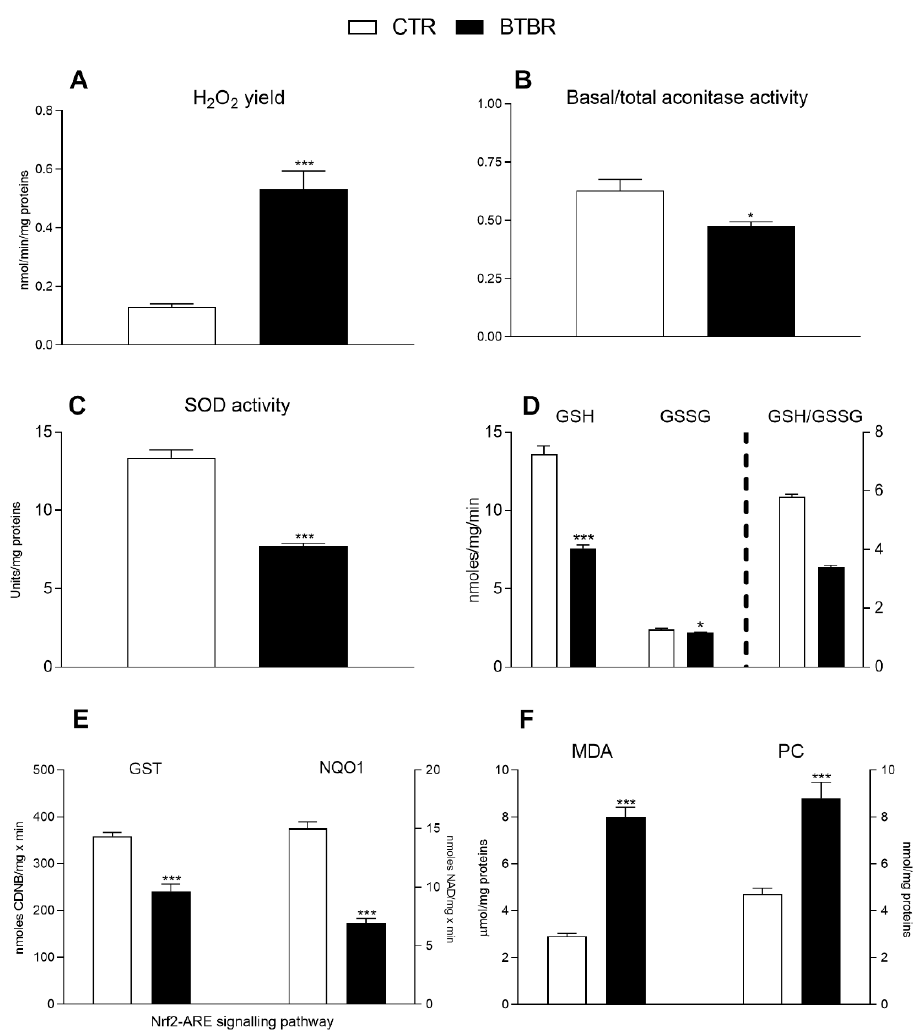
Figure 7. Hepatic oxidative stress profile and antioxidant/detoxifying defenses in control and BTBR mice. Hydrogen peroxide (H 2 O 2 ) release ( A ), basal/total aconitase ( B ) and superoxide dismutase (SOD) activity ( C ) were determined in hepatic isolated mitochondria. Reduced glutathione (GSH), glutathione oxidized (GSSG) content (( D ), left Y axis) and ratio GSH/GSSG (( D ), right Y axis), glu- tathione transferase (GST) and NAD(P)H Quinone Dehydrogenase (NQO1) levels ( E ) were evaluated in hepatic tissue. Hepatic levels of malondialdehyde (MDA) and protein carbonyls (PC) ( F ). Data are presented as means ± SEM from n = 7 animals/group. * p < 0.05, ** p < 0.01, *** p < 0.001, BTBR vs. Control (CTR).